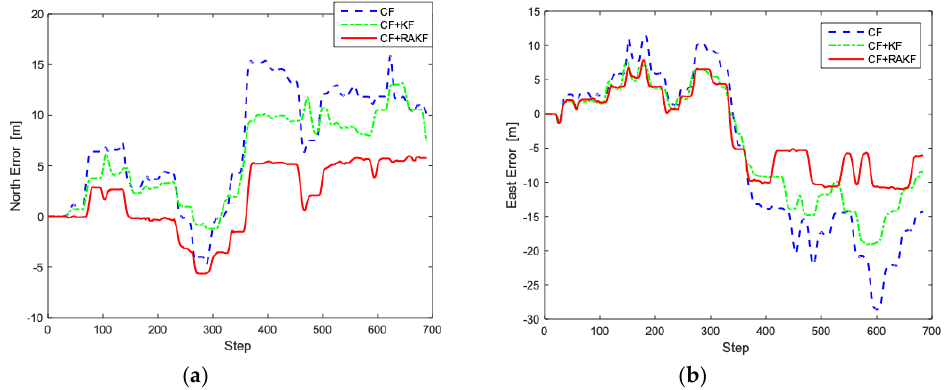
Figure 11. Trajectory analysis in walking under different heading estimation algorithms. ( a ) North error comparison; ( b ) East error comparison.